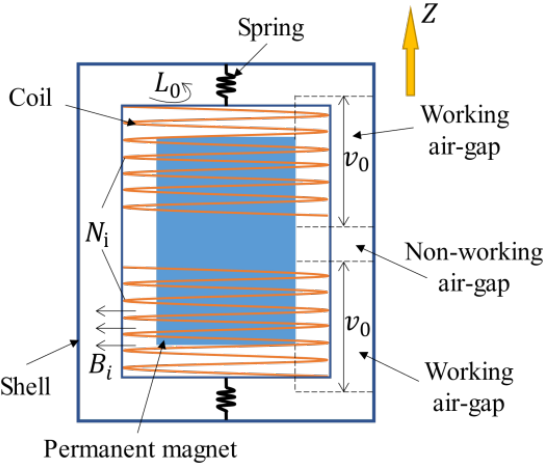
Figure 2. Equivalent model of electromagnetic velocity sensor.